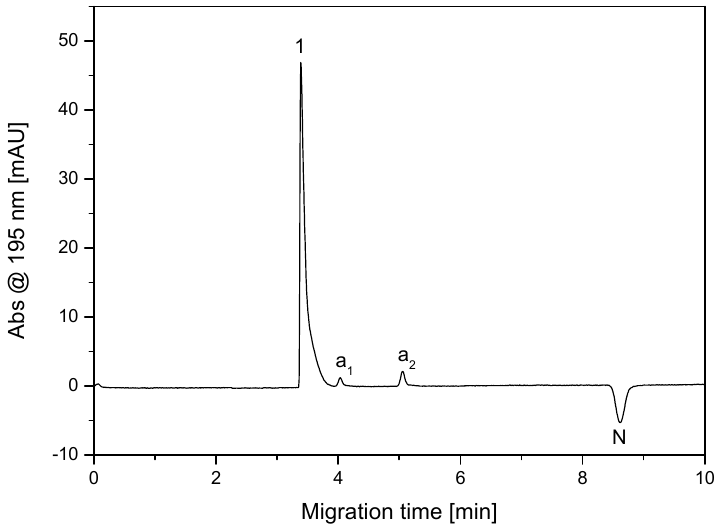
Figure 4. CZE analysis of dipeptide β -Ala-Tyr obtained by HPLC separation of an extract from the hemolymph of the larvae of Neobellieria bullata . 1, β -Ala-Tyr; a 1 , a 2 , non-identified admixtures; N, negative peak of water zone (with migration time identical as that of the neutral EOF marker (phenol)). BGE: 500 mM AcOH, pH 2.50; capillary: bare fused silica, total/effective length 393/290 mm, id/od 50/375 µ m; separation voltage: 20.0 kV; current 11.8 µ A. Sample concentration 0.5 mg/mL. For other experimental conditions, see Section